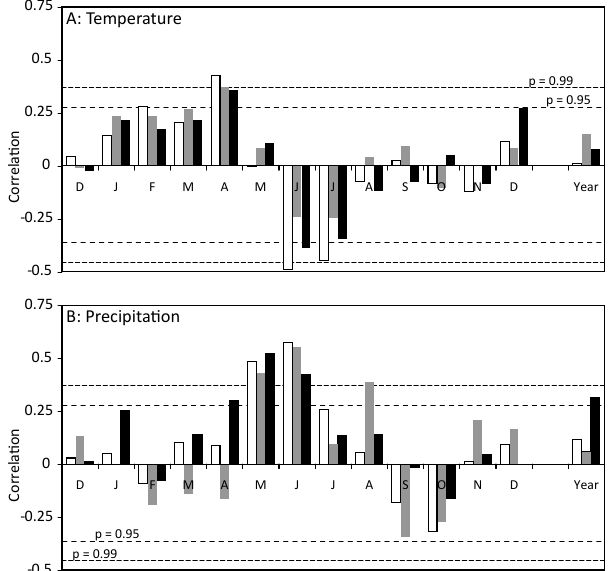
Fig. 8. Correlations of monthly average temperatures (A) and pre- cipitation sums (B) with yearly ring widths of the dolomite (white), calc. sandstone (gray), and flysch (black)